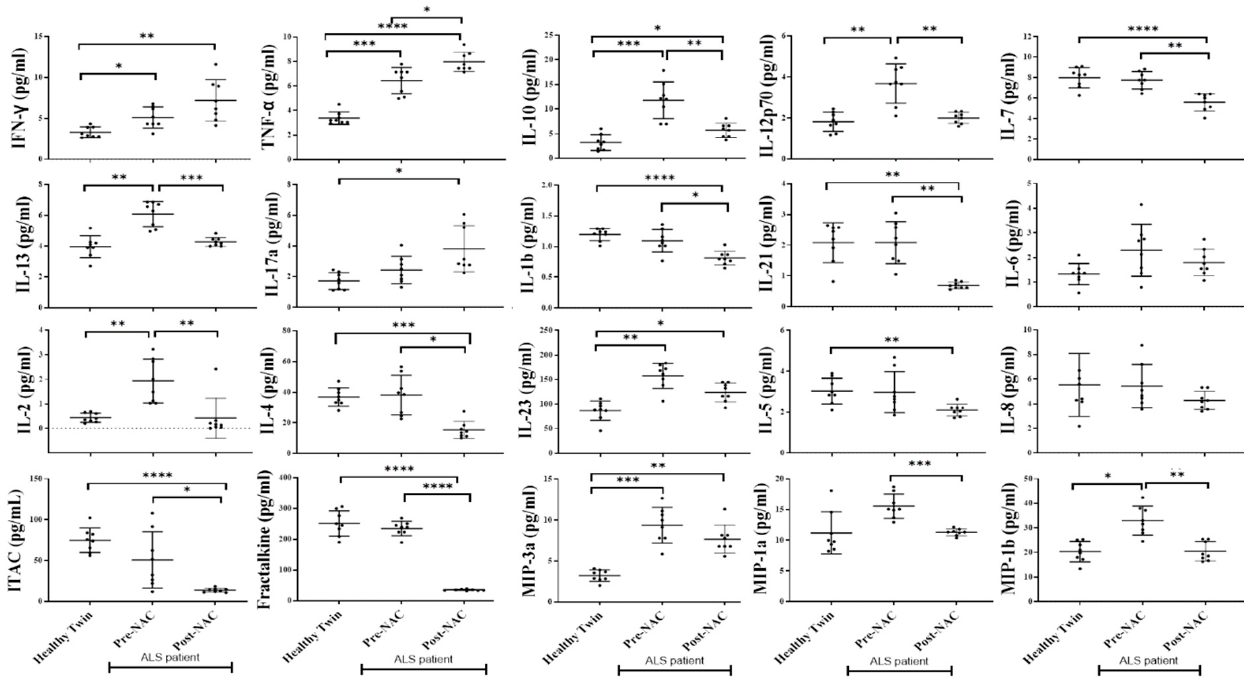
Figure 9. Weekly NAC injections in ALS patients decreased inflammatory cytokines in peripheral blood except IFN- γ , TNF- α , IL-17a and GMCSF. Sera were obtained from the peripheral blood of healthy individuals and ALS patients (before and after NAC injection in patient), and analyzed for the levels of cytokines, chemokines, and growth factors using a multiplex array kit ( n = 8). **** ( p -value < 0.0001), *** ( p -value 0.0001–0.001), ** ( p -value 0.001–0.01), * ( p -value 0.01–0.05).